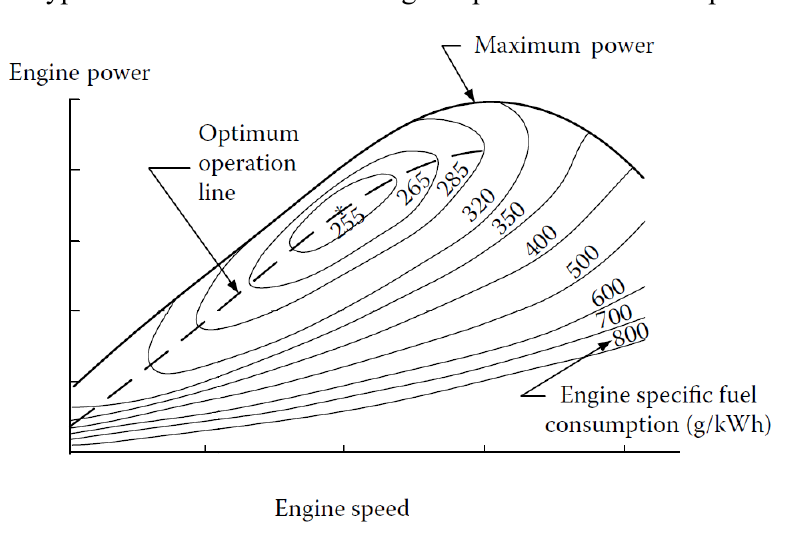
Figure 2. Typical internal combustion engine specific fuel consumption map